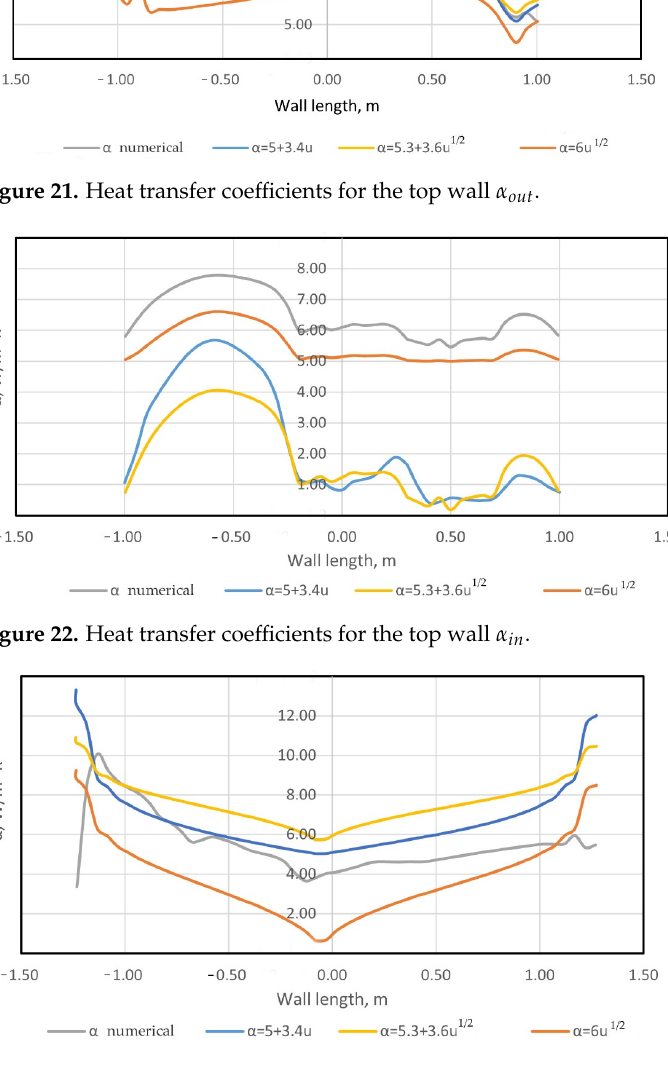
Figure 23. Heat transfer coefficients for the right wall 𝛼 𝑜𝑢𝑡 .